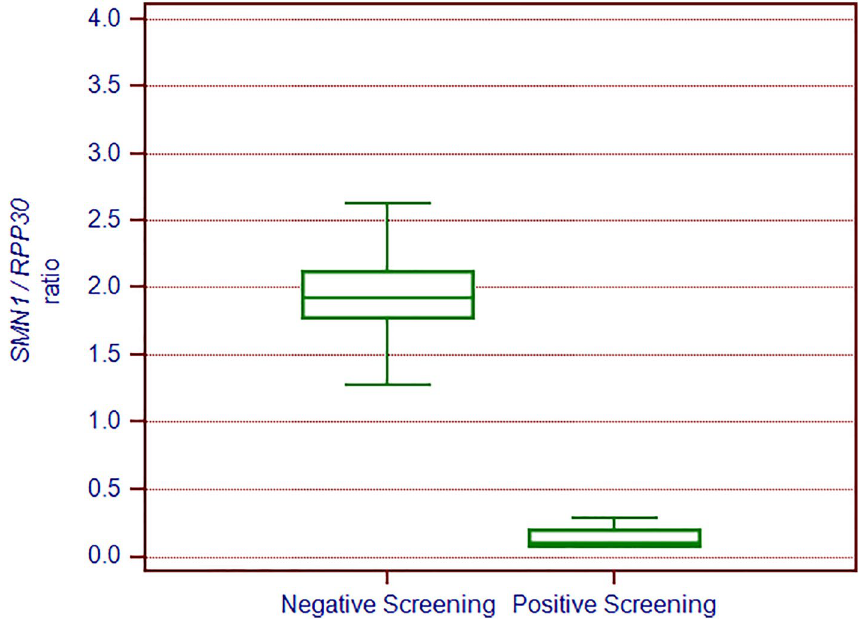
Figure 2. Box-and-whisker plot of the endpoint-fluorescence SMN1 to RPP30 ratio for negative (n = 136.330) and positive (n = 9) screening